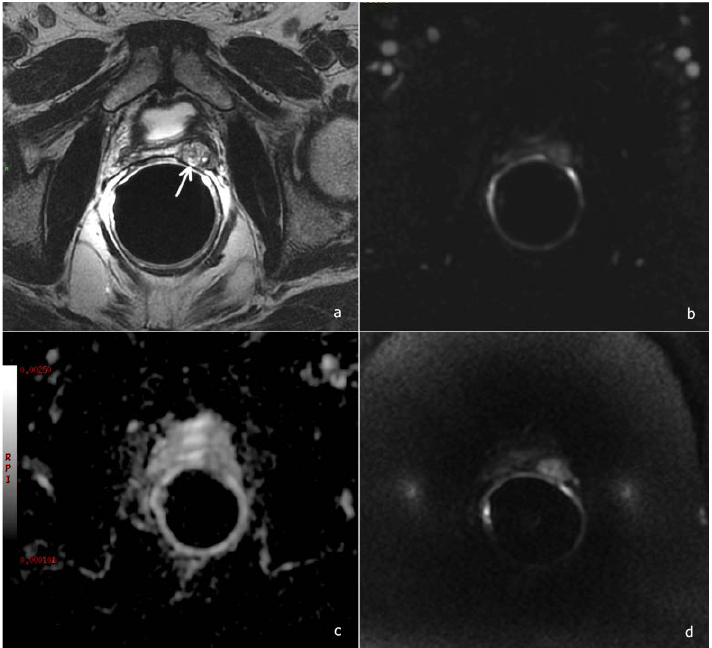
Figure 3. A PI-RR-score-2 patient, 68 years old, with a PSA value of 0.45 ng/mL. ( a ) T2-weighted image shows a hyperintense tissue in the rectovesical region (arrow), characterized by a homoge- neous and diffuse contrast enhancement, ( b ) non-pathological signal abnormality on the ADC map, ( c ) slightly hyperintensity on DWI, ( d ) a TRUS-guided biopsy was performed, documenting benign prostatic tissue remnants.